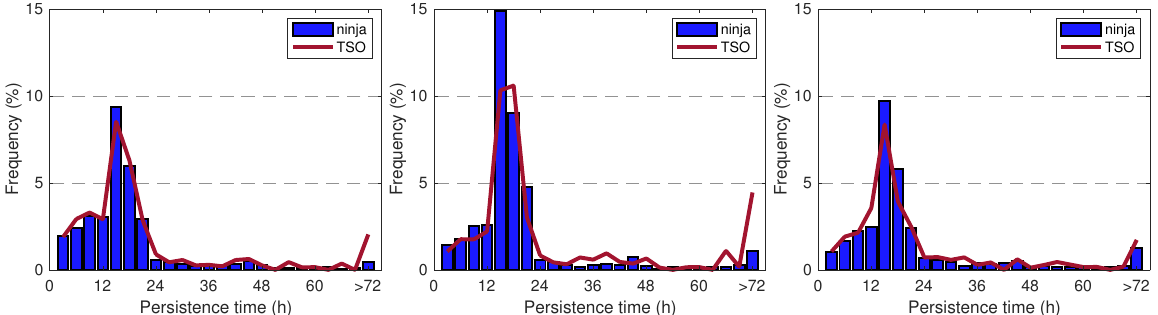
Figure 4. Frequency distribution of modeled (ninja) and actual (TSO) Dunkelflaute durations for Belgium ( left panel), Germany ( middle panel), and Denmark ( right panel). The modeled data, spanning the years of 1985 to 2016, were generated by the Renewables.ninja tool. Actual power production data from the TSOs are for the years 2015–2018.